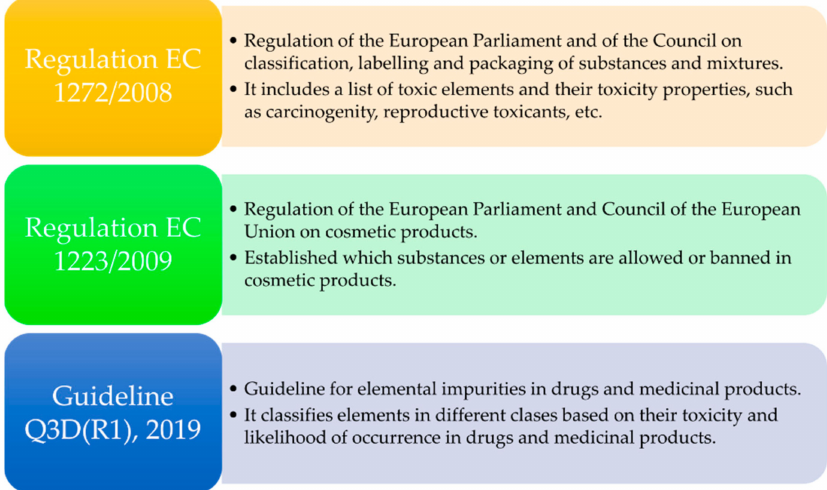
Figure 1. Main regulations [31–33] and guidelines used for the selection of elements, interpretation and discussions of results, ordered by year of publication or latest